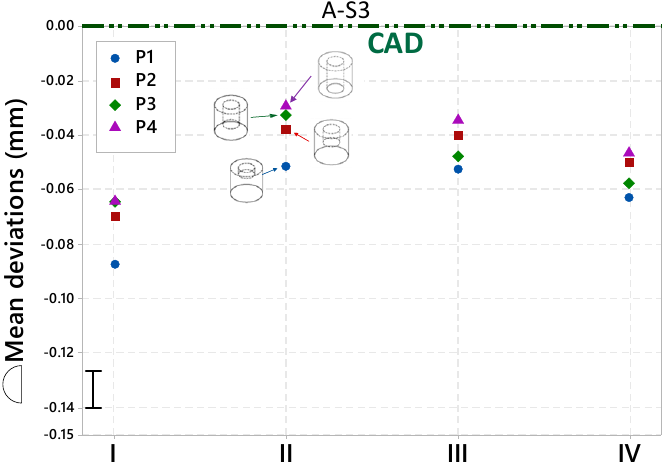
Figure 11. Three-dimensional (3D) profile mean deviations of the Shape A artifact having the biggest size S3, carried out at each post-processing step (as-built I, after stress relief II, after part removal III and after micro shot peening IV); P1–P4 pocket depths .